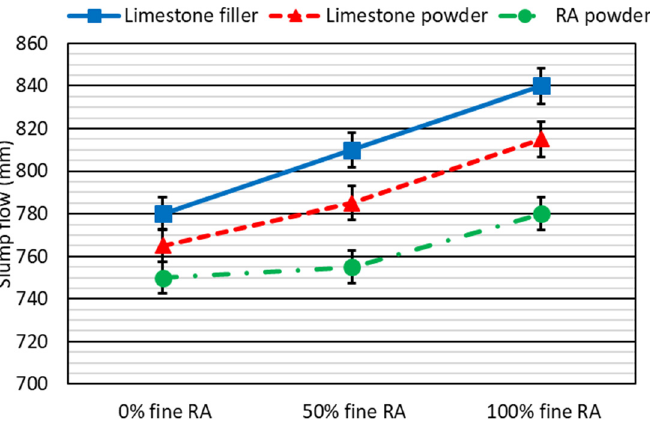
Figure 2. Slump flow of SCC